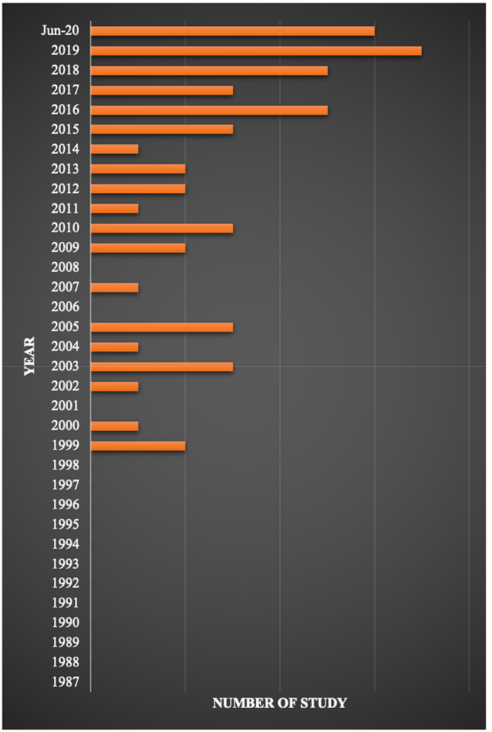
Figure 3. Publication year of the articles included in the